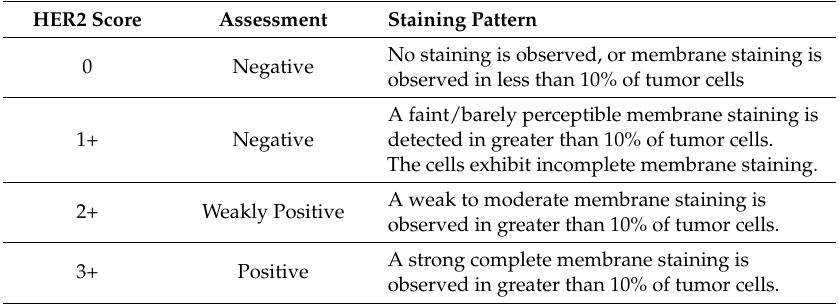
Table 1. Correlation between the intensity and percentage of membrane staining and the assigned HER2 scores [2]. Reproduced from [12] with permission.